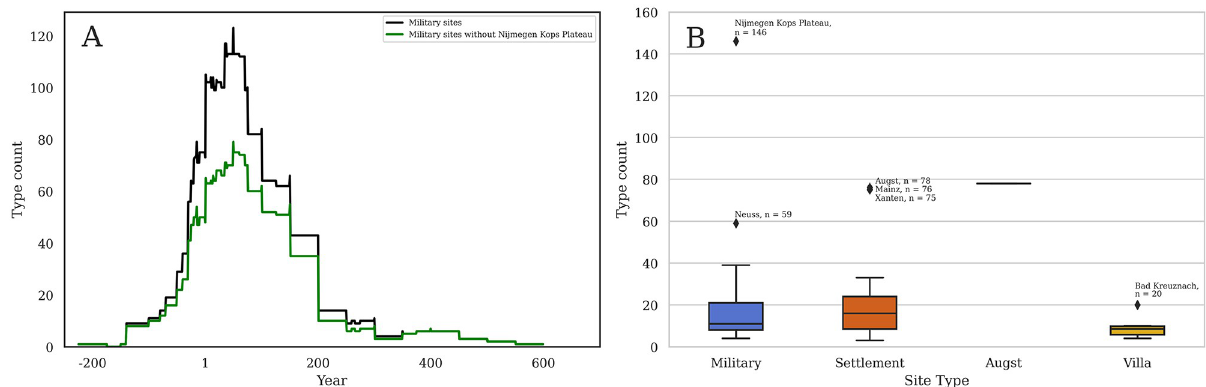
Fig 12. a-b: Military diversity. (a) Comparison of RAAD type number per site type per year according to type dates between all military sites excluding Nijmegen Kops Plateau (black) and Nijmegen Kops Plateau only (green). (b) Box and whisker plot of diversity of forms across settlement types with outliers